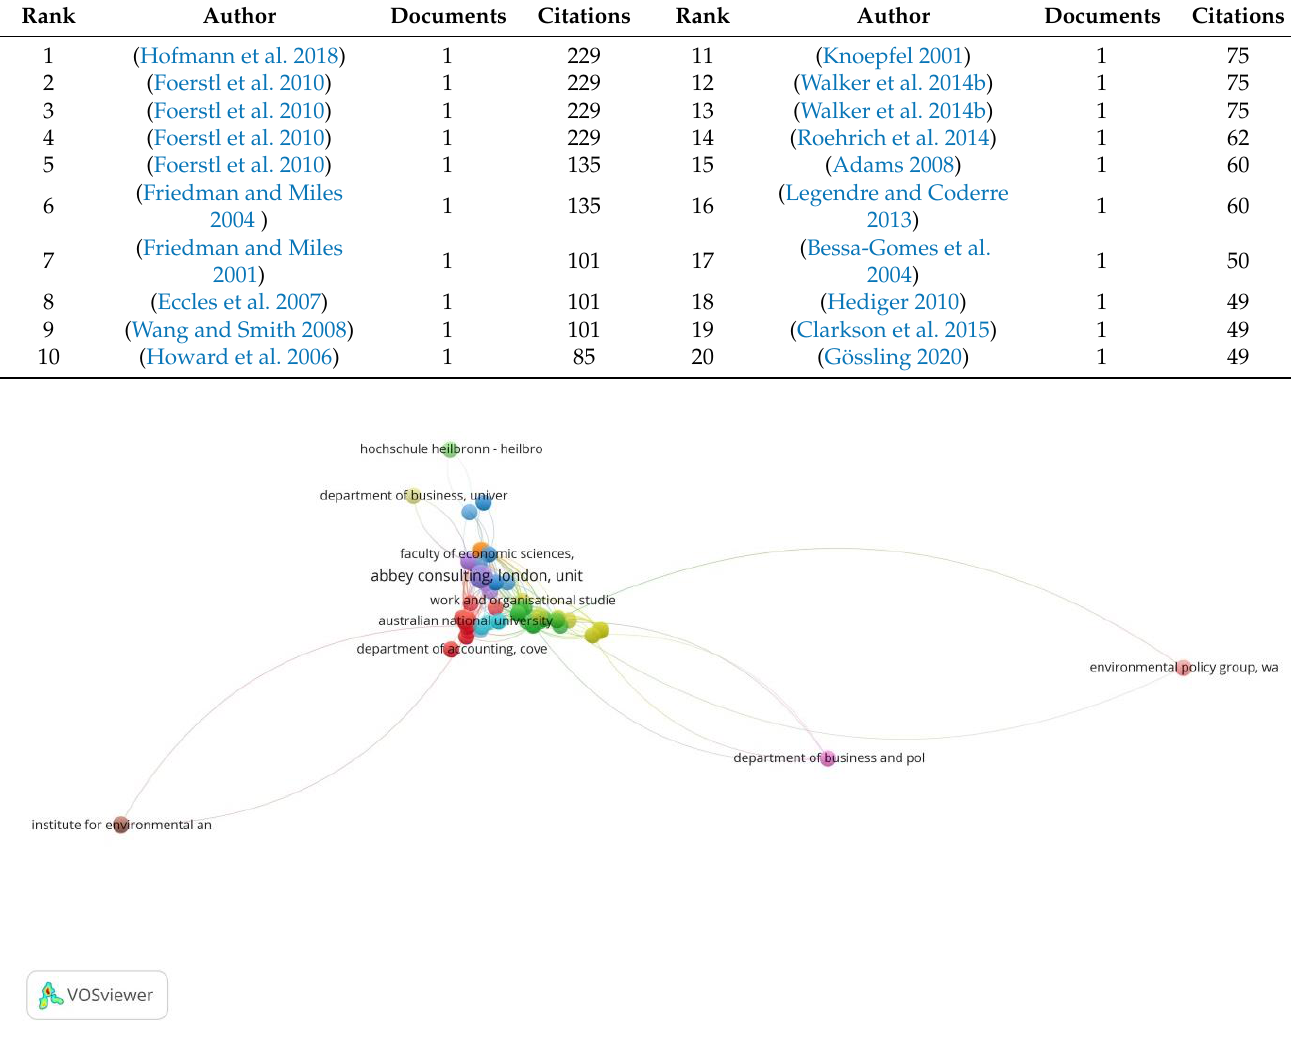
Figure 4. Organizations regarding keywords. Table 4. Organizations regarding keywords.